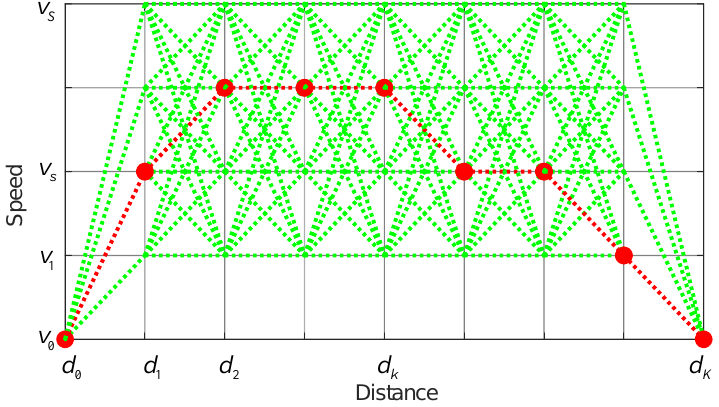
Figure 1. Speed profile according to dynamic program algorithm. (Green: possible paths, Red: optimal path).